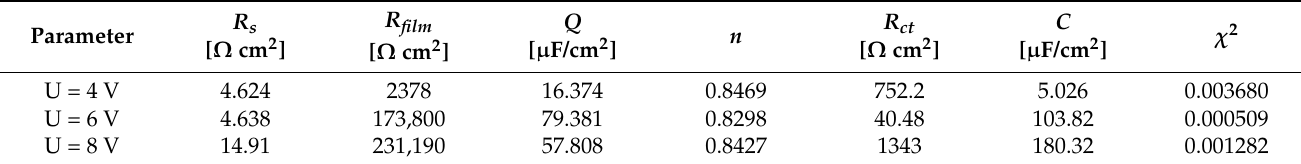
Table 4. Fitting parameters of EEC model for TC4 in 10% NaNO 3 solution.